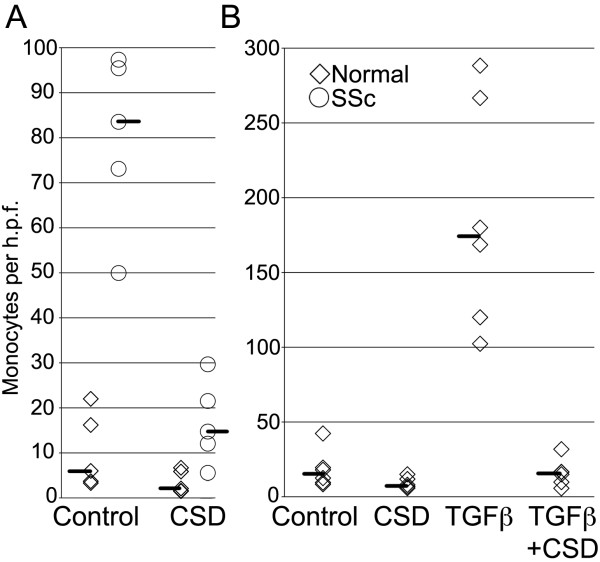
Monocyte migration in vitro. The migration of normal and SSc-ILD monocytes toward CXCL12, the effect of TGFβ on normal monocyte migration and the ability of caveolin scaffolding domain (CSD) peptide to inhibit migration were quantified as described in Materials and methods. Each symbol represents the results obtained with cells from a different donor. The median value obtained in each category is indicated by a line. (A) Normal versus SSC-ILD ± CSD. Each symbol represents one subject. Note the almost sevenfold increase in migration in SSc-ILD lung tissue and the almost complete inhibition of migration by CSD peptide. (B) Normal ± transforming growth factor β (TGFβ) ± CSD. Each symbol represents one subject. Note the 15-fold increase in migration induced by TGFβ and the almost complete inhibition of migration by CSD peptide.